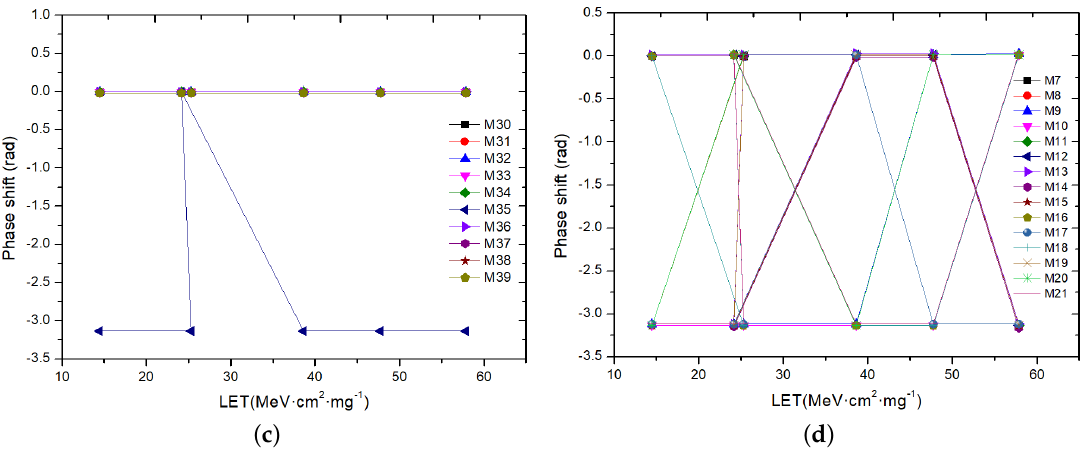
Figure 6. INP output phase shift due to impacts on the transistors. ( a ) MB; ( b ) VCO; ( c ) CML2CMOS converter; ( d ) FD2.